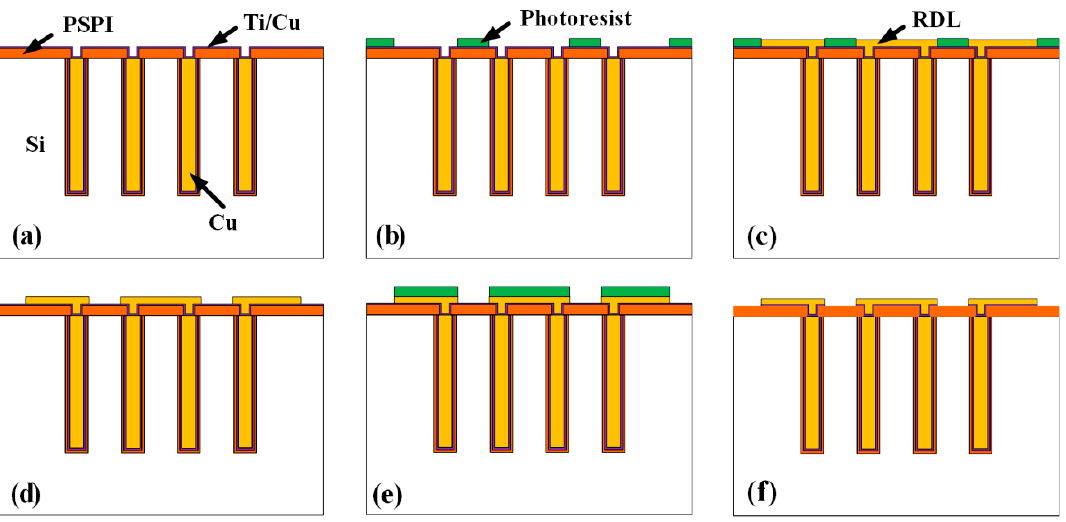
Figure 5. Schematic of the semi-additive process: ( a ) sputtering of barrier and seed layer, ( b ) patterning of RDL area, ( c ) RDL electroplating, ( d ) removal of photoresist, ( e ) patterning to protect RDL area, ( f ) wet etching of excess barrier and seed layer and removal of photoresist.